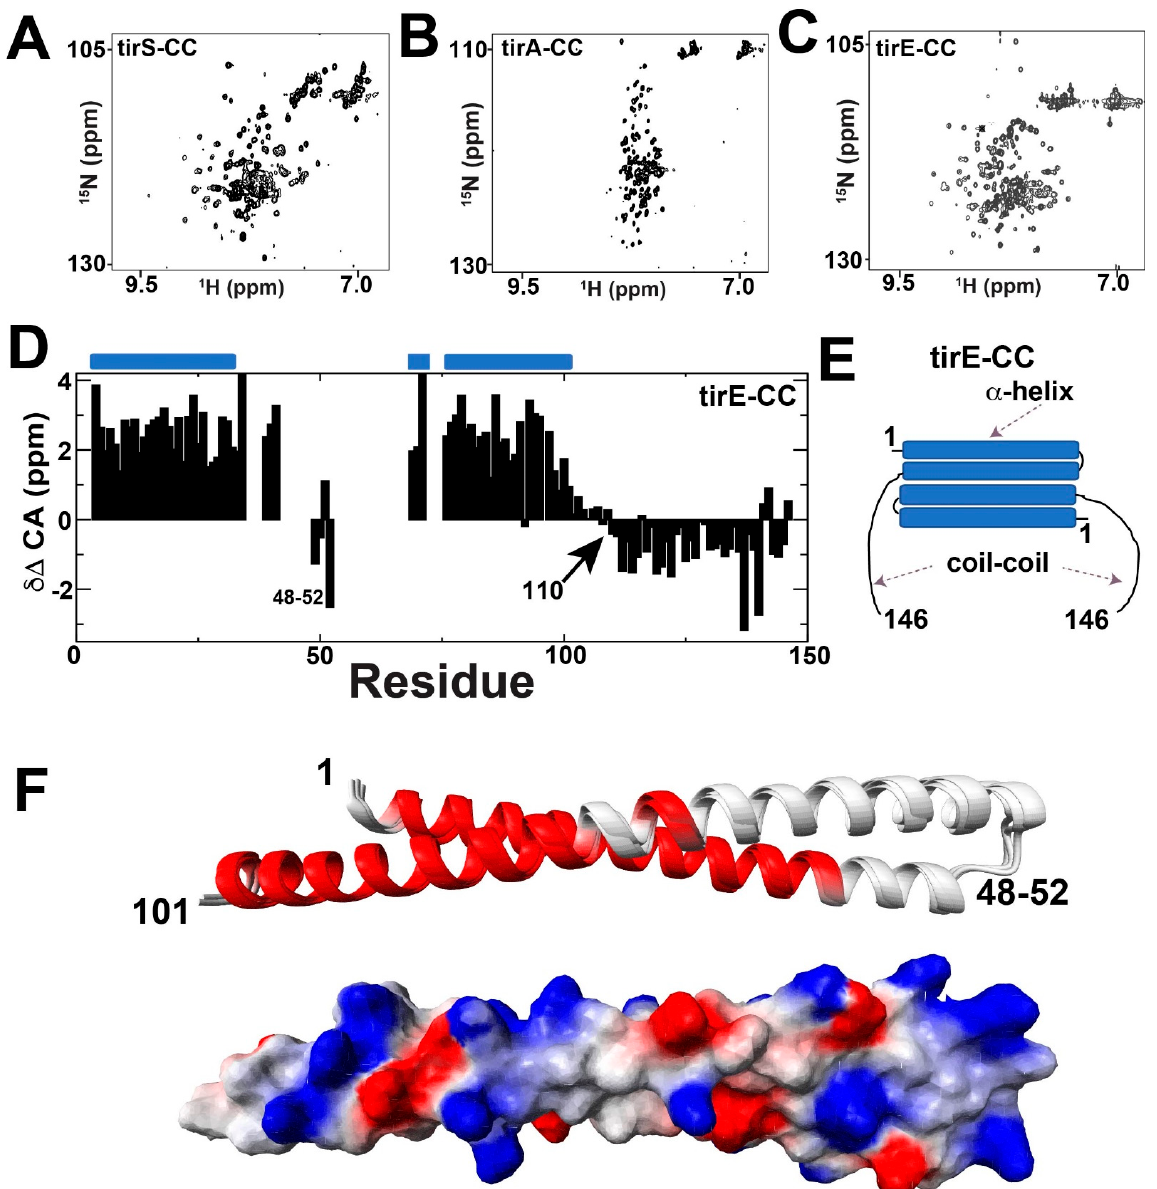
Figure 4. NMR studies of TIR-containing CC domains. ( A ) tirS CC in 50 mM Na 2 HPO 4 , 500 mM NaCl, pH 6.5. ( B ) tirA CC in 50 mM Na 2 HPO 4 , 50 mM NaCl, pH 6.5. ( C ) tirE CC in 50 mM Na 2 HPO 4 , 150 mM NaCl, pH 6.5. ( D ) CA chemical shift propensities ( δΔ CA) of tirE-CC were calculated by the